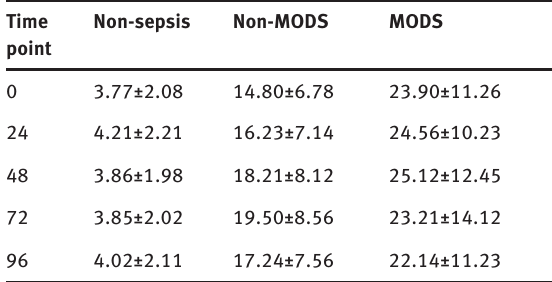
Table 2: Serum neopterin concentration of different time points in different